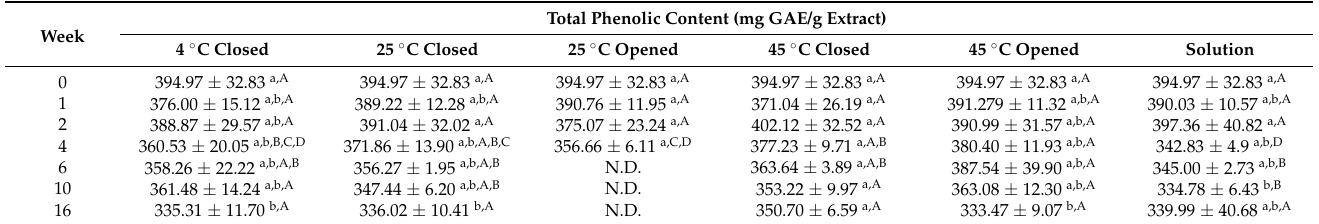
Table 2. Stability in total phenolic compounds of the ethanolic extract under various